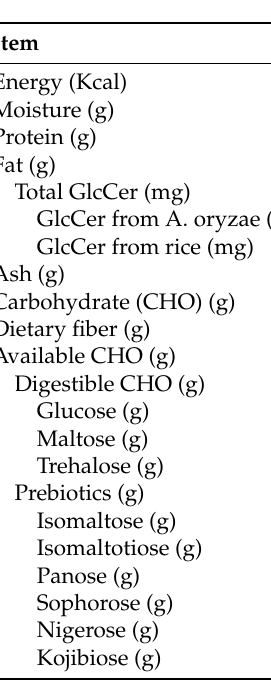
Table 1. Nutritional values of test beverages (per 118 g in a